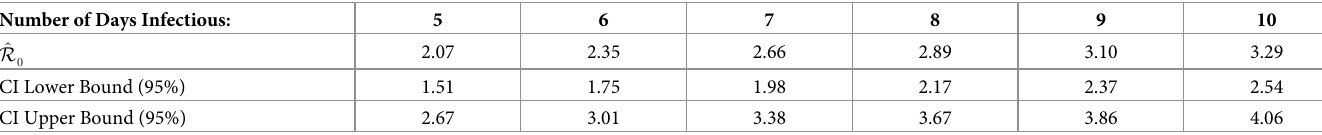
Table 1. Estimates of the basic reproduction number ( R